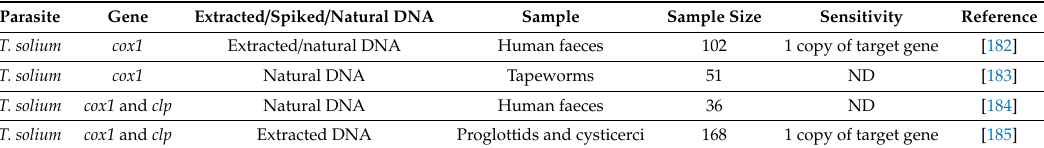
Table 18. Publications found in the US National Library of Medicine National Institutes of Health (NCBI-PubMed) reporting the standardisation of the LAMP technique as a useful tool for diagnosing taeniasis / cysticercosis in the definitive